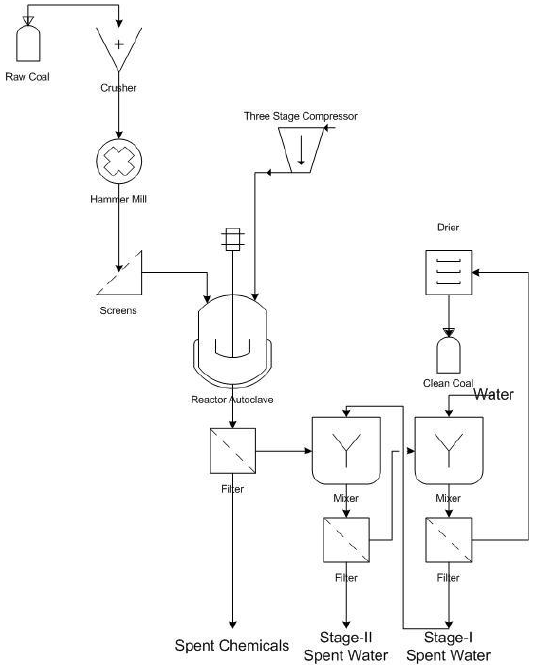
Figure 1. Process flow diagram.